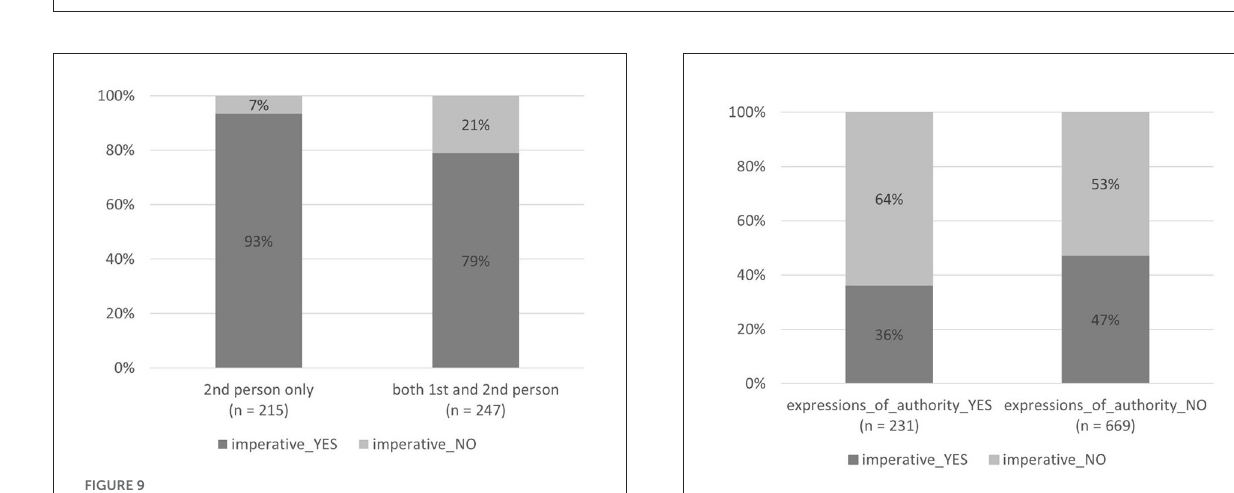
Imperative mood and expressions of authority (four types of person usage